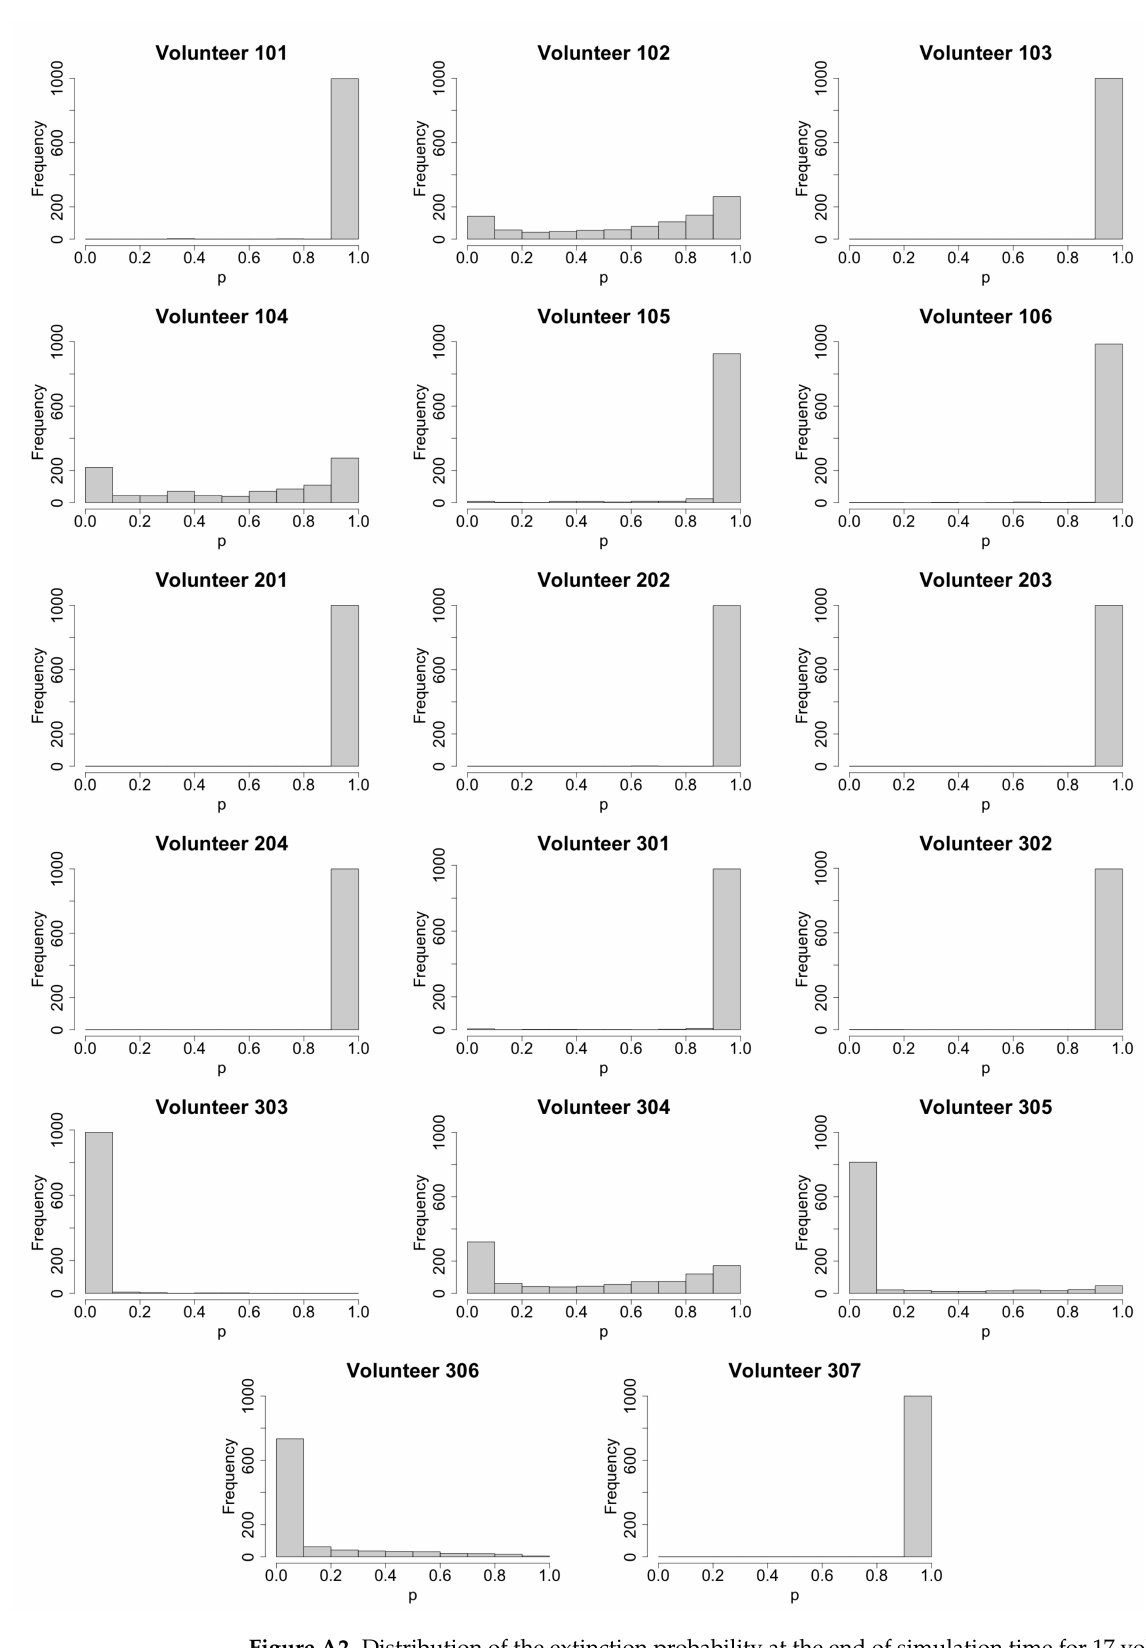
Figure A2. Distribution of the extinction probability at the end of simulation time for 17